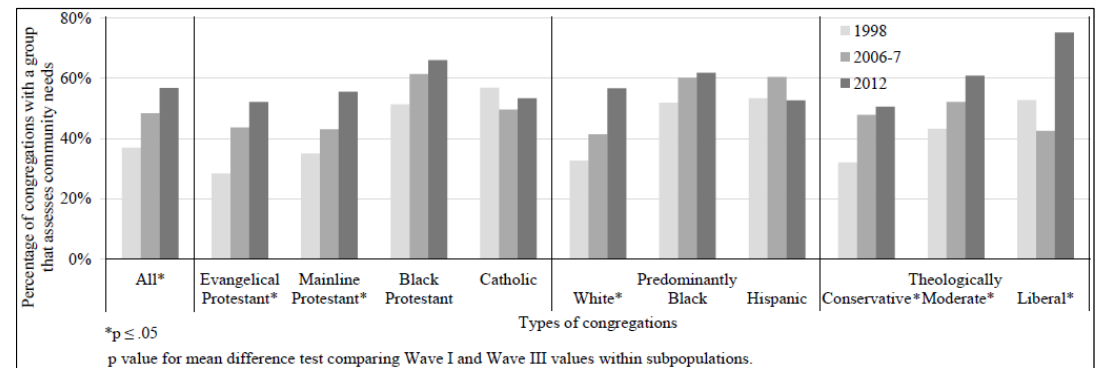
Figure 2. The percentage of congregations by subpopulation with a group that assesses community needs by wave.